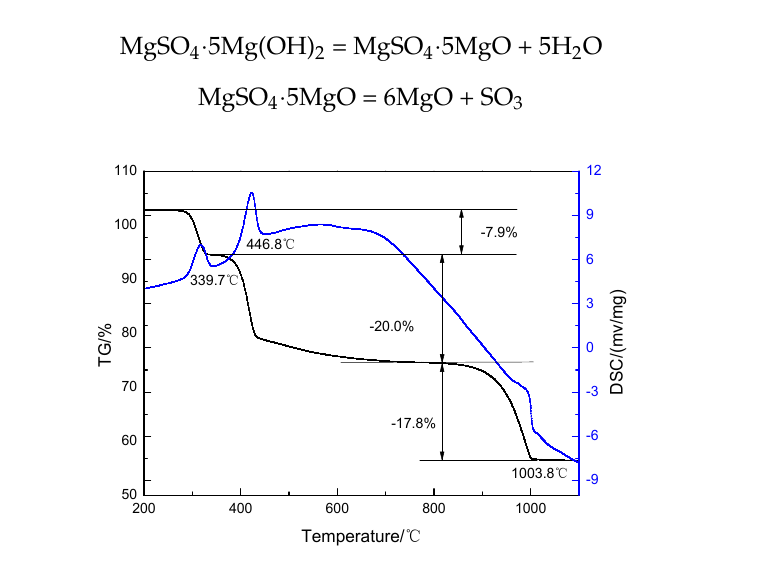
Figure 18. Thermogravimetry-differential scanning calorimetry TG-DSC curves of the hydrothermal product. Table 7. The comparison of mass loss of the product and theoretical value. Table 7. The comparison of mass loss of the product and theoretical